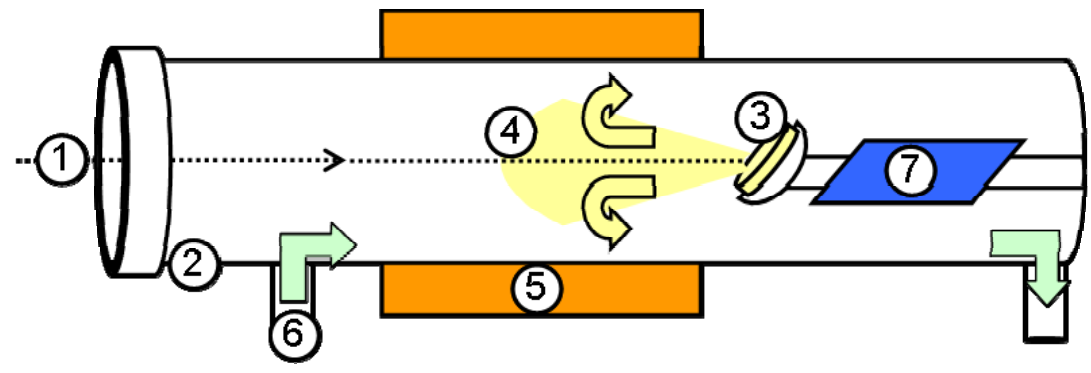
Figure 2. Pulsed laser ablation scheme (1) Laser beam. (2) Quartz tube. ( 3) V (4) Recoiling plume. (5) Furnace. (6) Oxygen carrier gas inlet. (7) Cooled collection